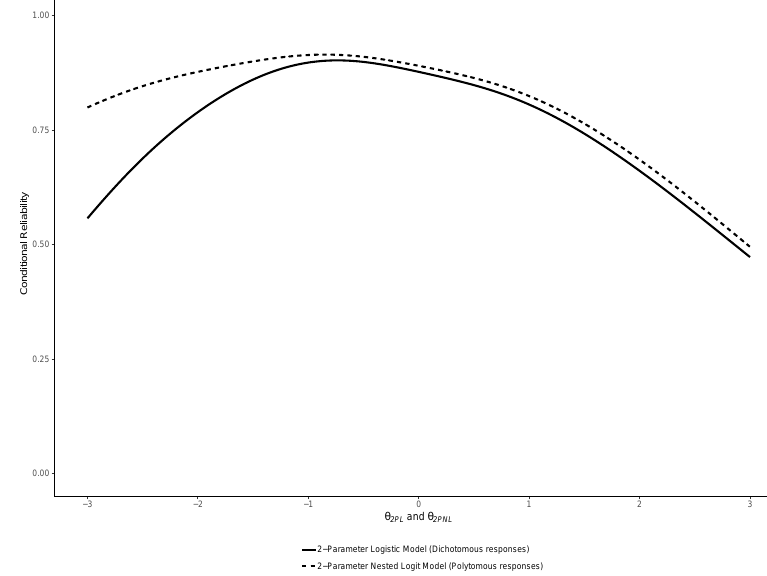
Figure 8. Comparison of the reliability functions of the 2-Parameter Logistic (2PL) and Nested Logit (2PNL) models.